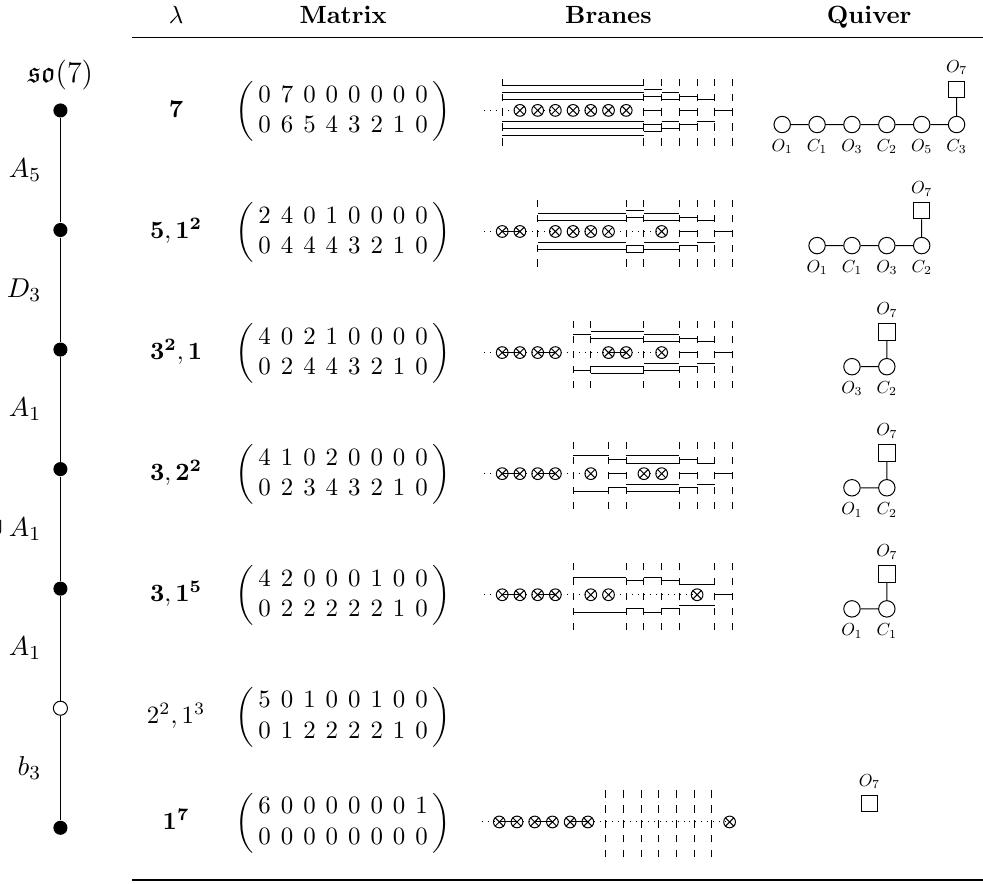
Table 24. Example of the recovery of the branes and the quiver with M H = (cid:22) O (cid:21) (cid:26) so (7) from the results obtained applying the matrix formalism . The transition from ( 3 ; 1 5 ) to ( 1 7 ) is ~ b 3 , formed by a composition of A 1 and b 3